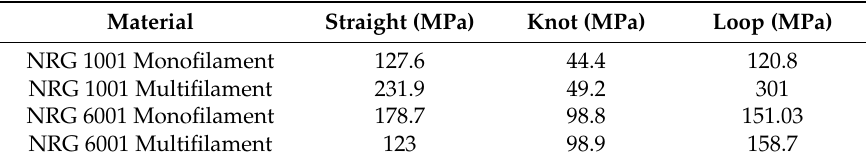
Table 5. Average Young’s modulus.